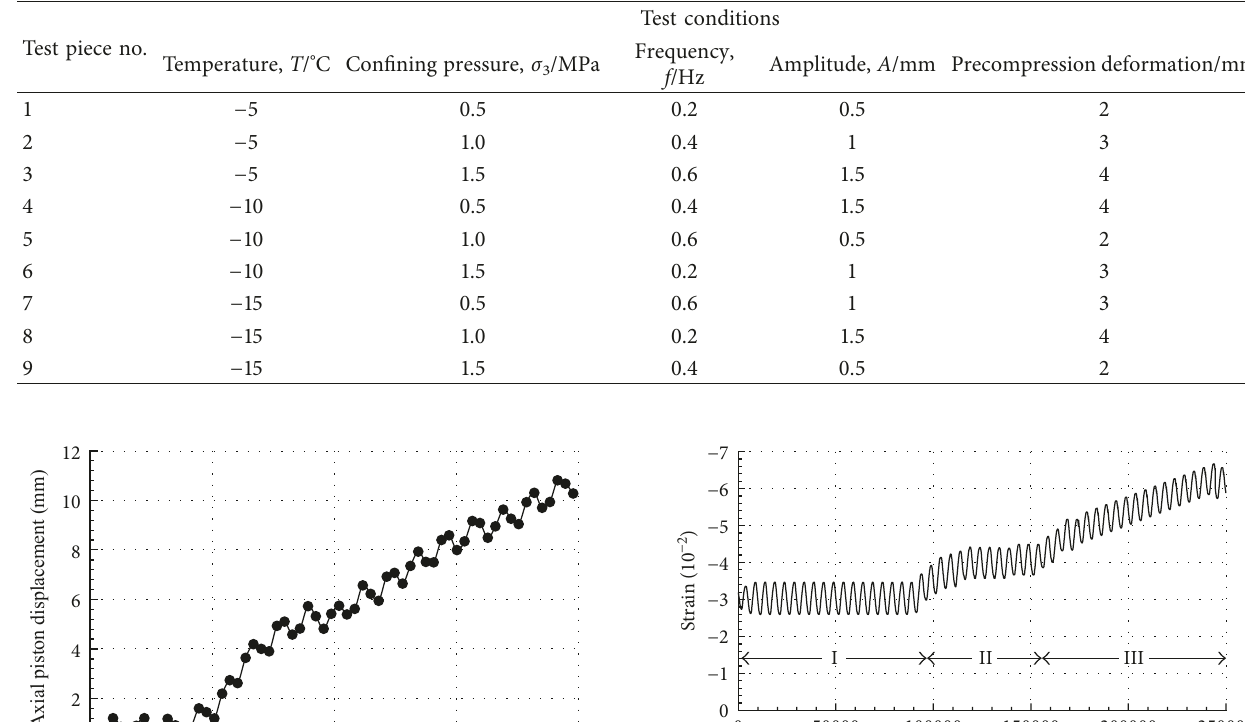
Table 3: Dynamic triaxial shear test of frozen clay with orthogonal method. Test piece no.